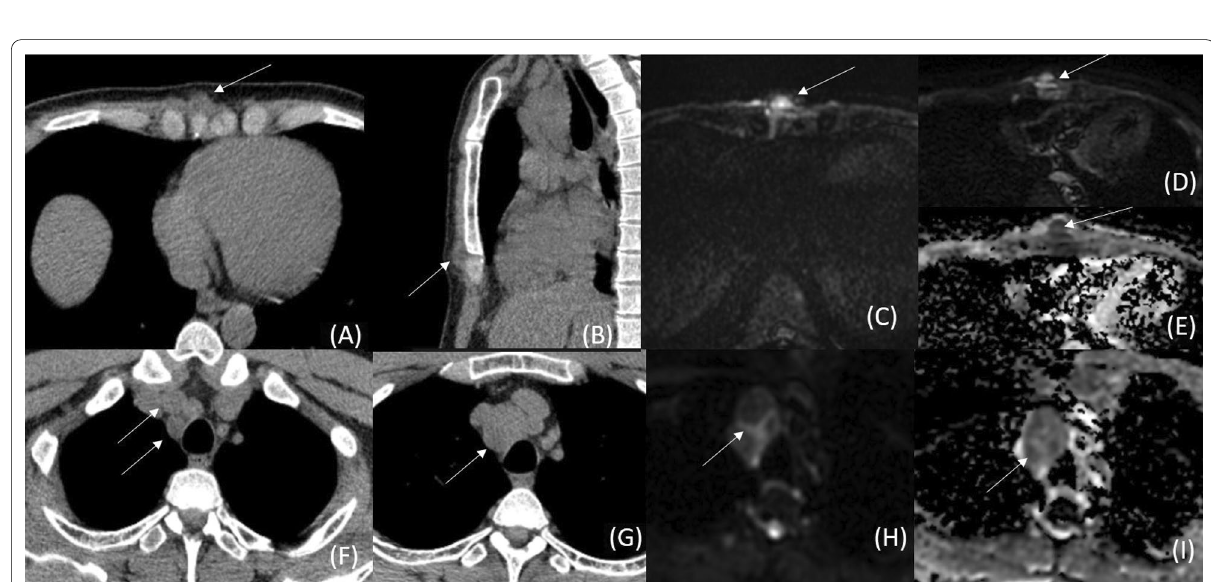
Fig. 10 Tubercular chondro-sternal arthritis with necrotic mediastinal lymphadenopathy. CT images of a 41-year-old male show joint widening and effusion in right 6th chondro-sternal joint with collection extending into subcutaneous plane (white arrow in A, B ), MRI shows hyperintense collection on STIR ( C ) with diffusion restriction on DWI ( D ) and ADC ( E ). CT images show multiple enlarged mediastinal lymph nodes (arrows in F , G ), MRI shows diffusion restriction in the nodes (arrows in H , I